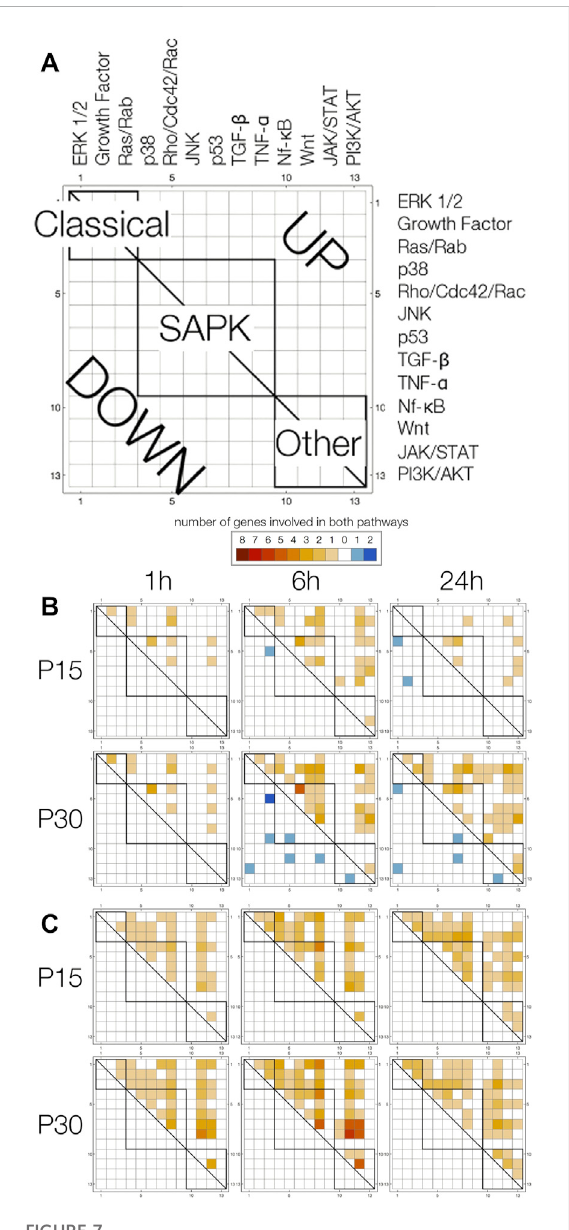
FIGURE 7 Pathway array plots for multiple-pathway annotated genes plot the number of genes annotated with any two pathways. (A) General label for all plots. Pathways are arranged (1 = ERK1/2 ... 13 = PI3K/AKT) by Classical, SAPK and Other families, and boxesaredrawntoindicatepathwaysareinthesamefamily(intra- family v. inter-family). Upregulated genes are fi lled in on the upper triangleinashadeoforange,anddownregulatedgenesare fi lledin on the lower triangle in a shade of blue. (B) Pathway array plots for (4 or less) — pathway annotated genes differentially expressed at 1, 6 and 24 h in P15 and P30 animals. (C) Pathway array plotsfor (5 or more) — pathway annotated genes differentially expressed at 1,6 and 24 h in P15 and P30